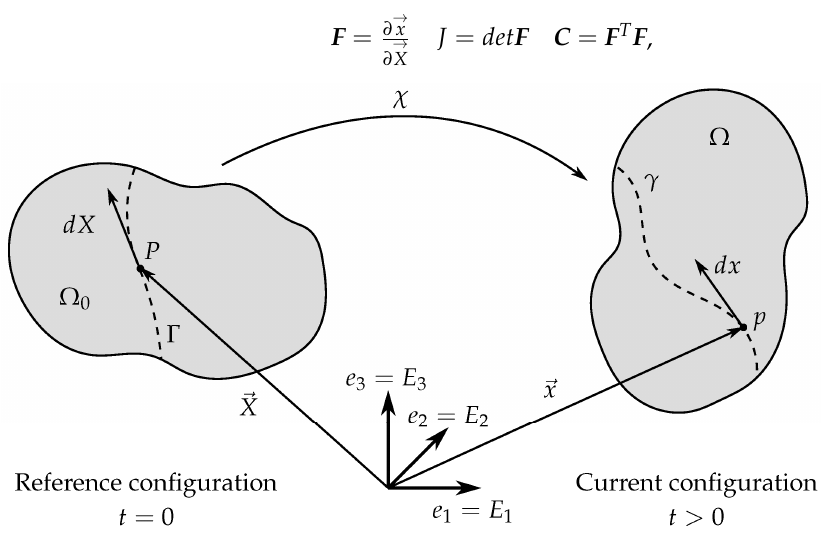
Figure 8. Visualization of different descriptive approaches for the movement and deformation of a continuum body in space by two selected configurations in time ( t = 0 is the reference configuration, t > 0 is the current configuration). Describing a movement or deformation relative to the coordinates of a reference configuration (undeformed) is called the Lagrangian description, while describing it relative to the coordinates of a current configuration (deformed) is called the Eulerian description [105].